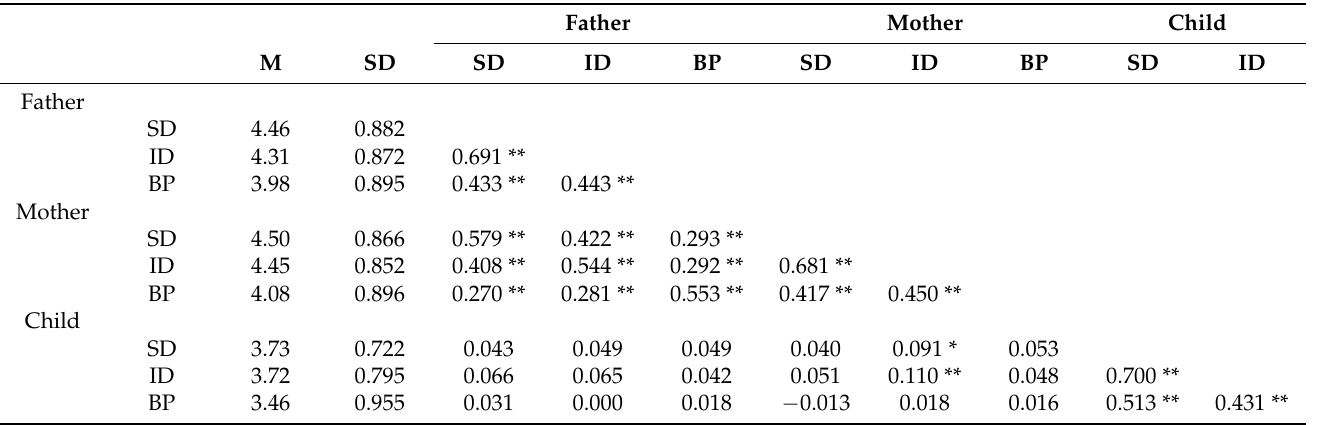
Table 1. Pearson correlations among